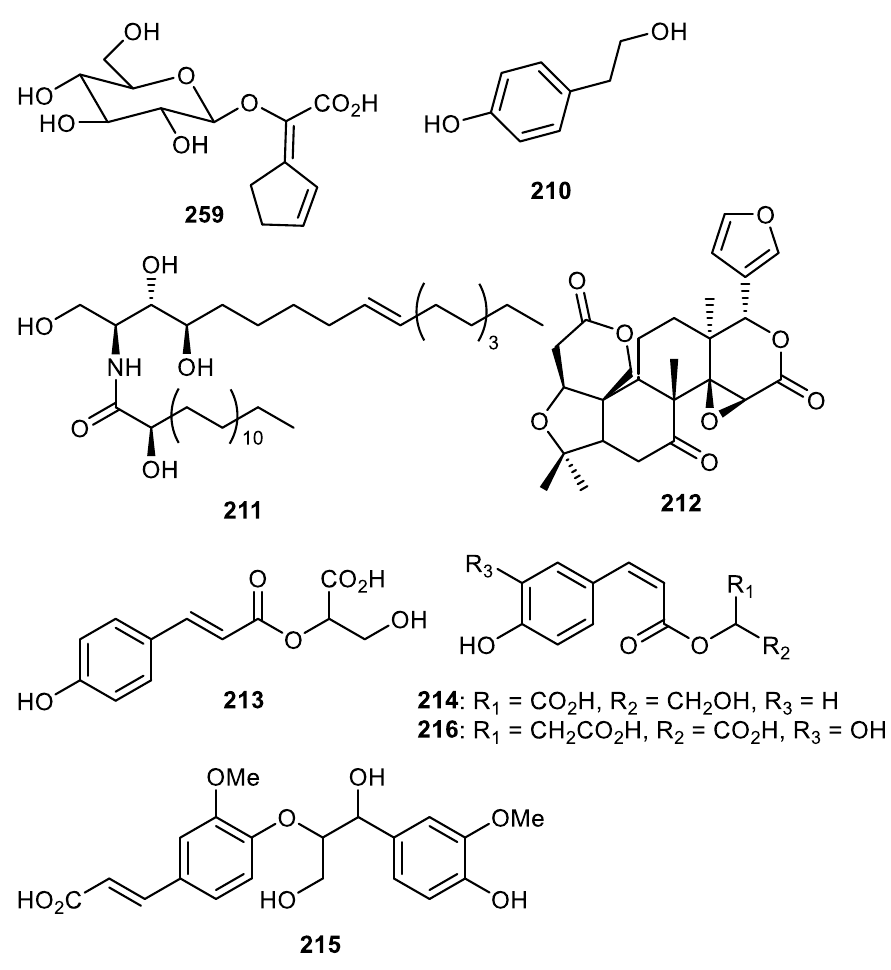
Figure 26. Structures of compounds 209 – 216 .